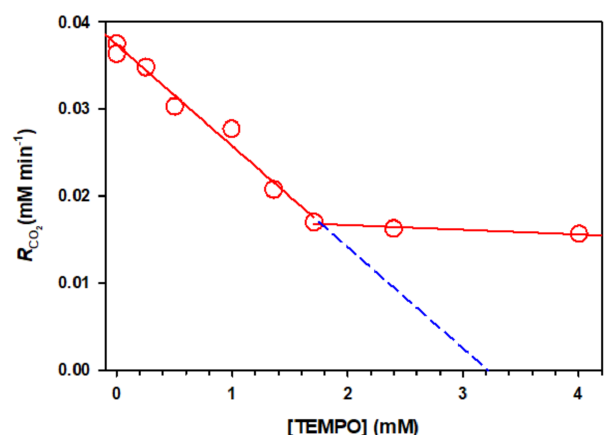
Figure 4. Rates of CO 2 (g) evolution ( R CO ) vs. the initial concentration of TEMPO for the 313 nm 2 photolysis of fully deaerated 100 mM PA aqueous solutions at 293 K [5]. Copyright 2006, American Chemical Society.